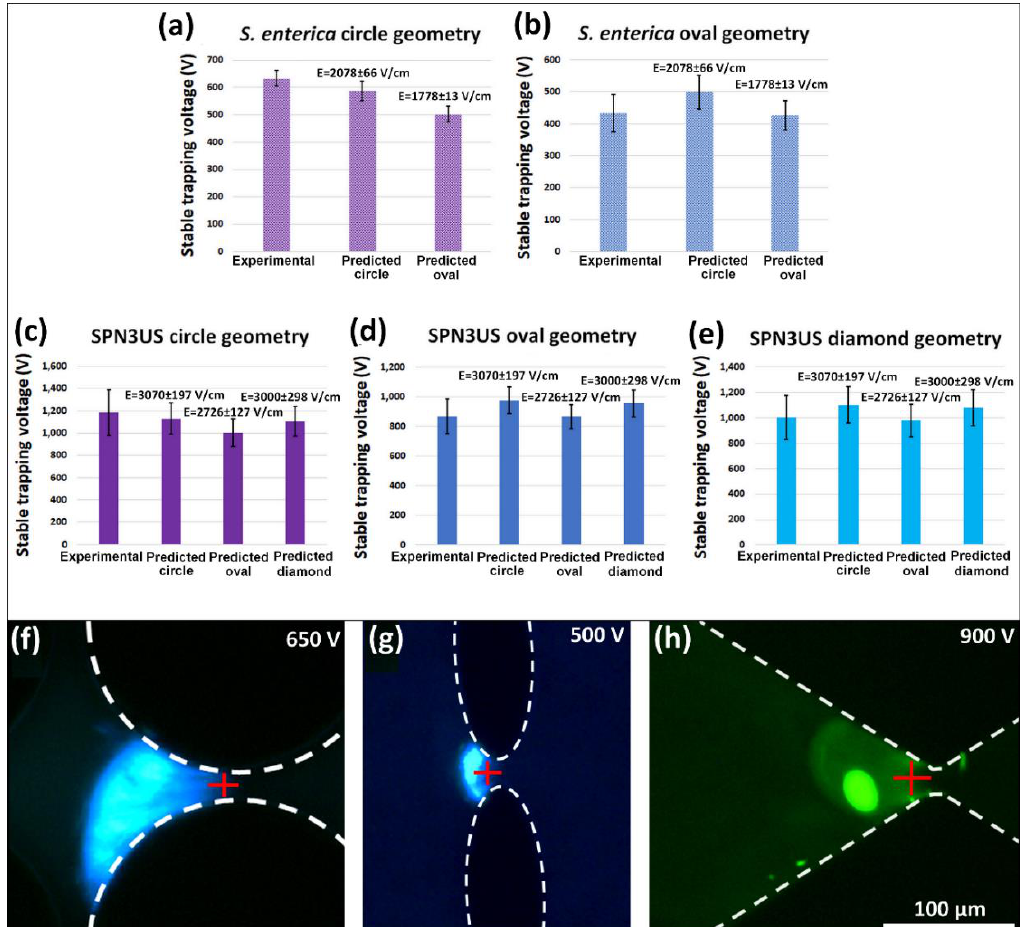
Figure 4. Comparison of experimental stable trapping voltages (sTVs) and estimated sTVs. Experimental and estimated sTVs for ( a , b ) S. enterica and for ( c – e ) SPN3US. All estimated sTV values were obtained using the eE EEC values reported in Figure 3 (reported above the relevant bars in the plots) and applying those eE EEC values to the geometry described in the title of the graphs. The experimental sTV values are the average applied voltages for the experimental images used to predict sTV. Estimations of sTV for S. enterica ( a ) in the circle posts, ( b ) in the oval posts. Estimations of sTV for SPN3US ( c ) in the circle posts, ( d ) in the oval posts and ( e ) in the diamond posts. ( f – h ) Images of trapped microorganisms illustrating the location used for estimations (red cross). Trapping of ( f ) S. enterica in circle posts at 650 V, ( g ) S. enterica in oval posts at 500 V, and ( h ) SPN3US in diamond posts at 900 V.